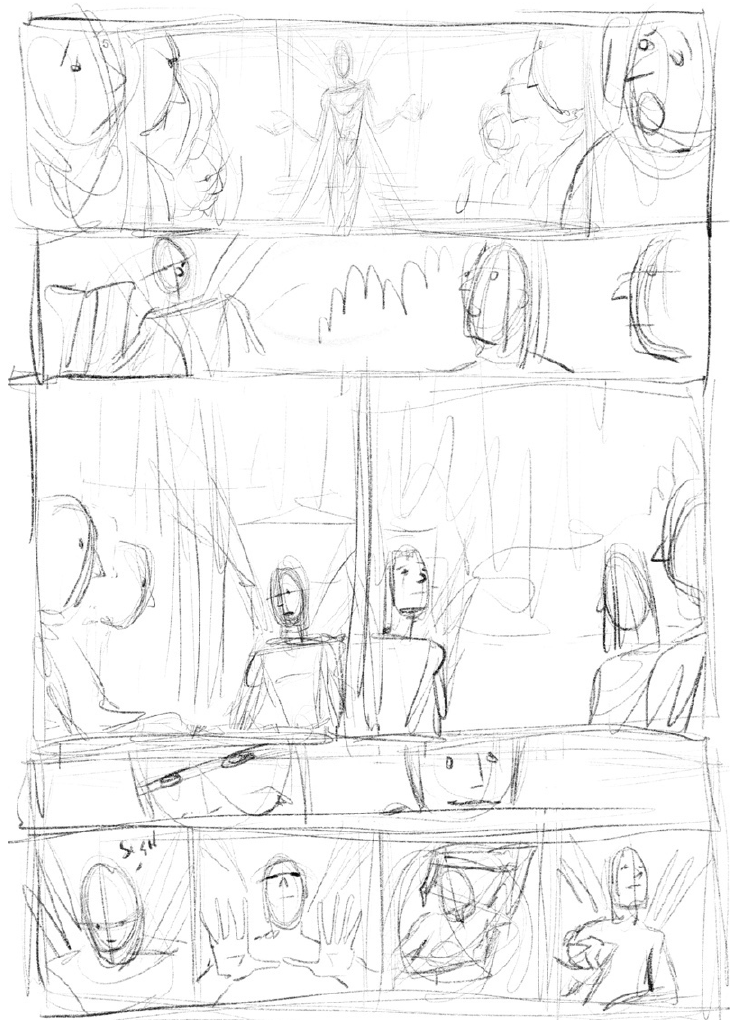
Figure 1: Storyboard. Hotel